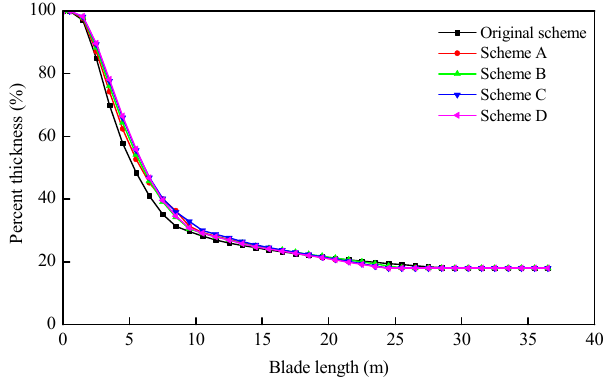
Figure 16. Comparison of percent thickness distribution.